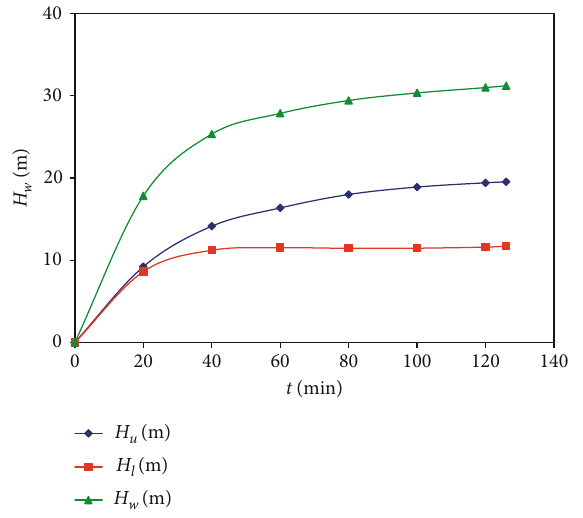
Figure 10: Change of L